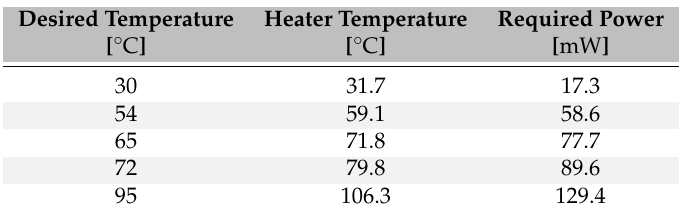
Table 1. Calculated required heater temperatures and powers when a desired temperature at the top of the chamber is assumed. The calculations are based on Equations (2) and (3).